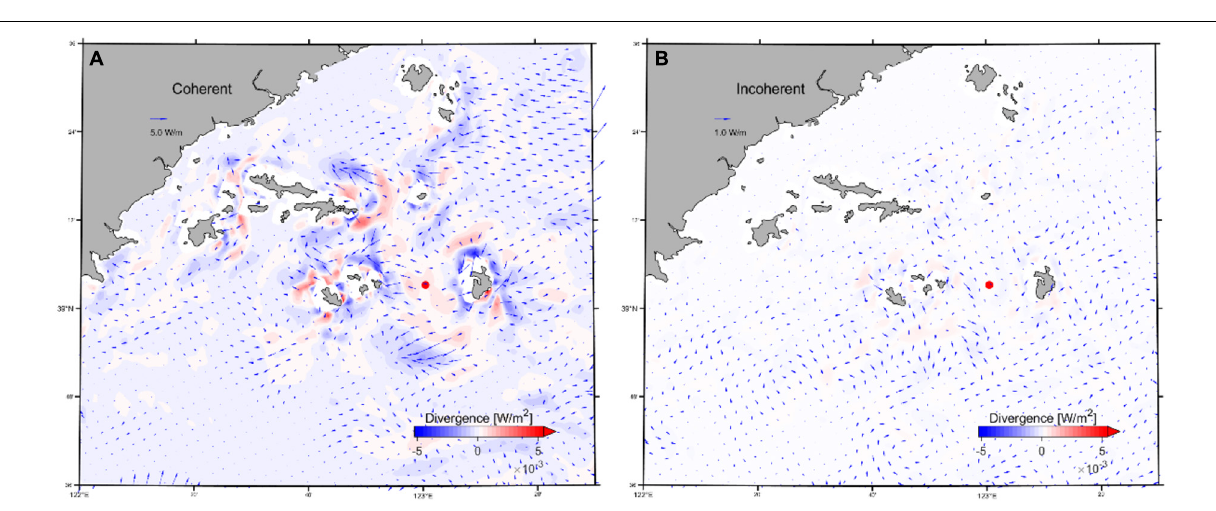
FIGURE 13 | (A) The coherent baroclinic energy flux ( F coh , arrow W/m) and the flux divergence ( ∇ H · F c o h , W/m 2 ) derived for 10 tidal cycles for the M 2 internal tide around the Changshan islands. (B) The incoherent baroclinic flux ( F incoh , arrow W/m) and flux divergence ( ∇ H · F incoh , W/m 2 ) for the same region. ADCP mooring location is represented as red